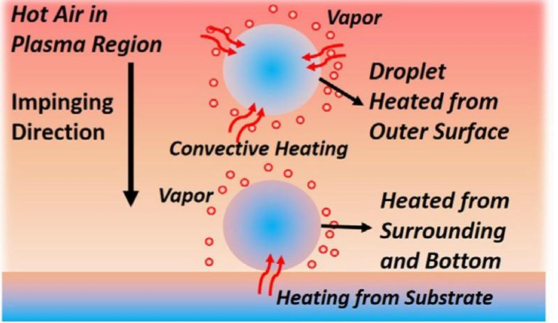
Figure 15. Heating mechanism of an impinging droplet on a DBD plasma actuator surface (adapted from Liu et al. [149] with the permission of